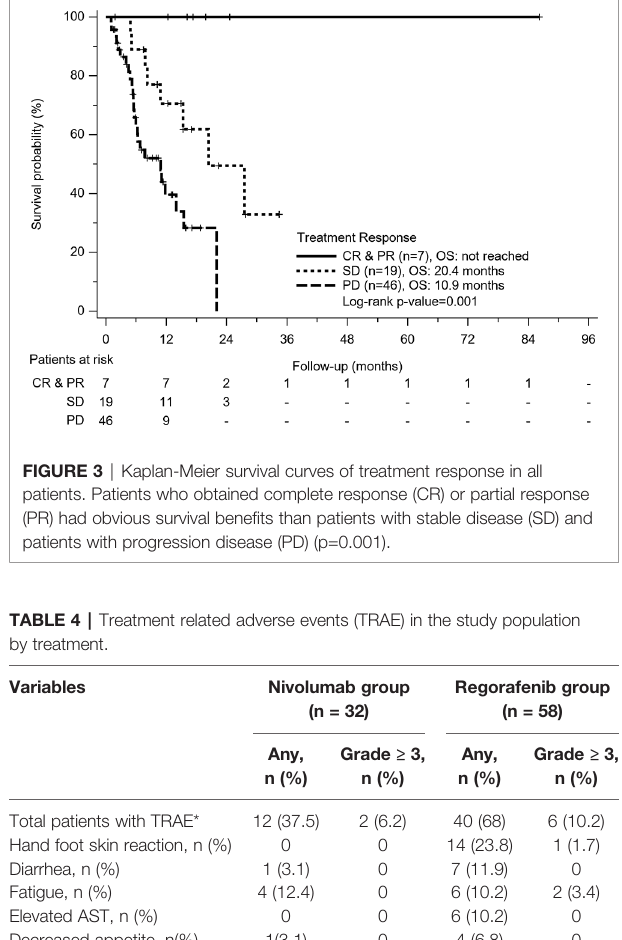
*The comparison of total patients with TRAE between two groups was signi fi cant different